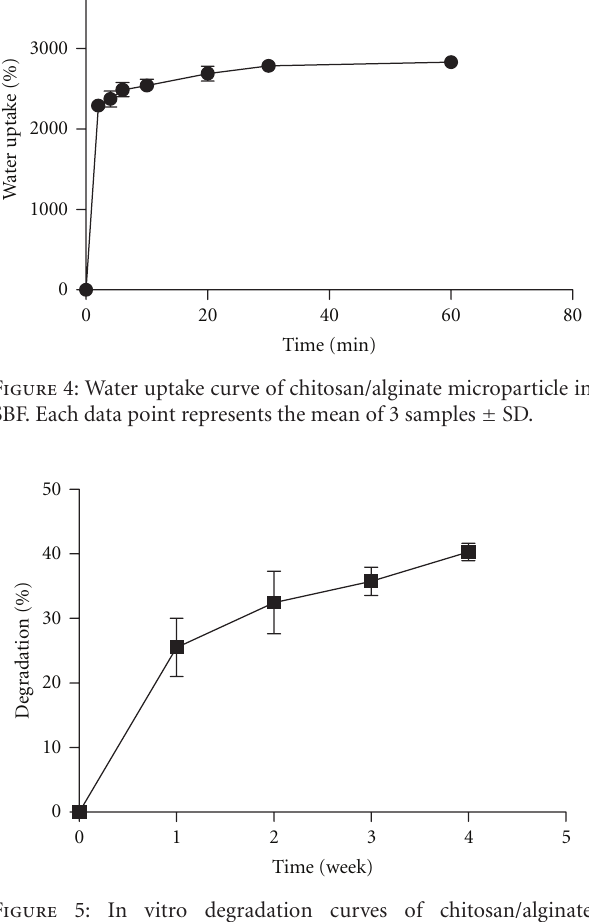
Figure 5: In vitro degradation curves of chitosan/alginate microparticle in SBF. Each data point represents the mean of 3 samples ± SD.